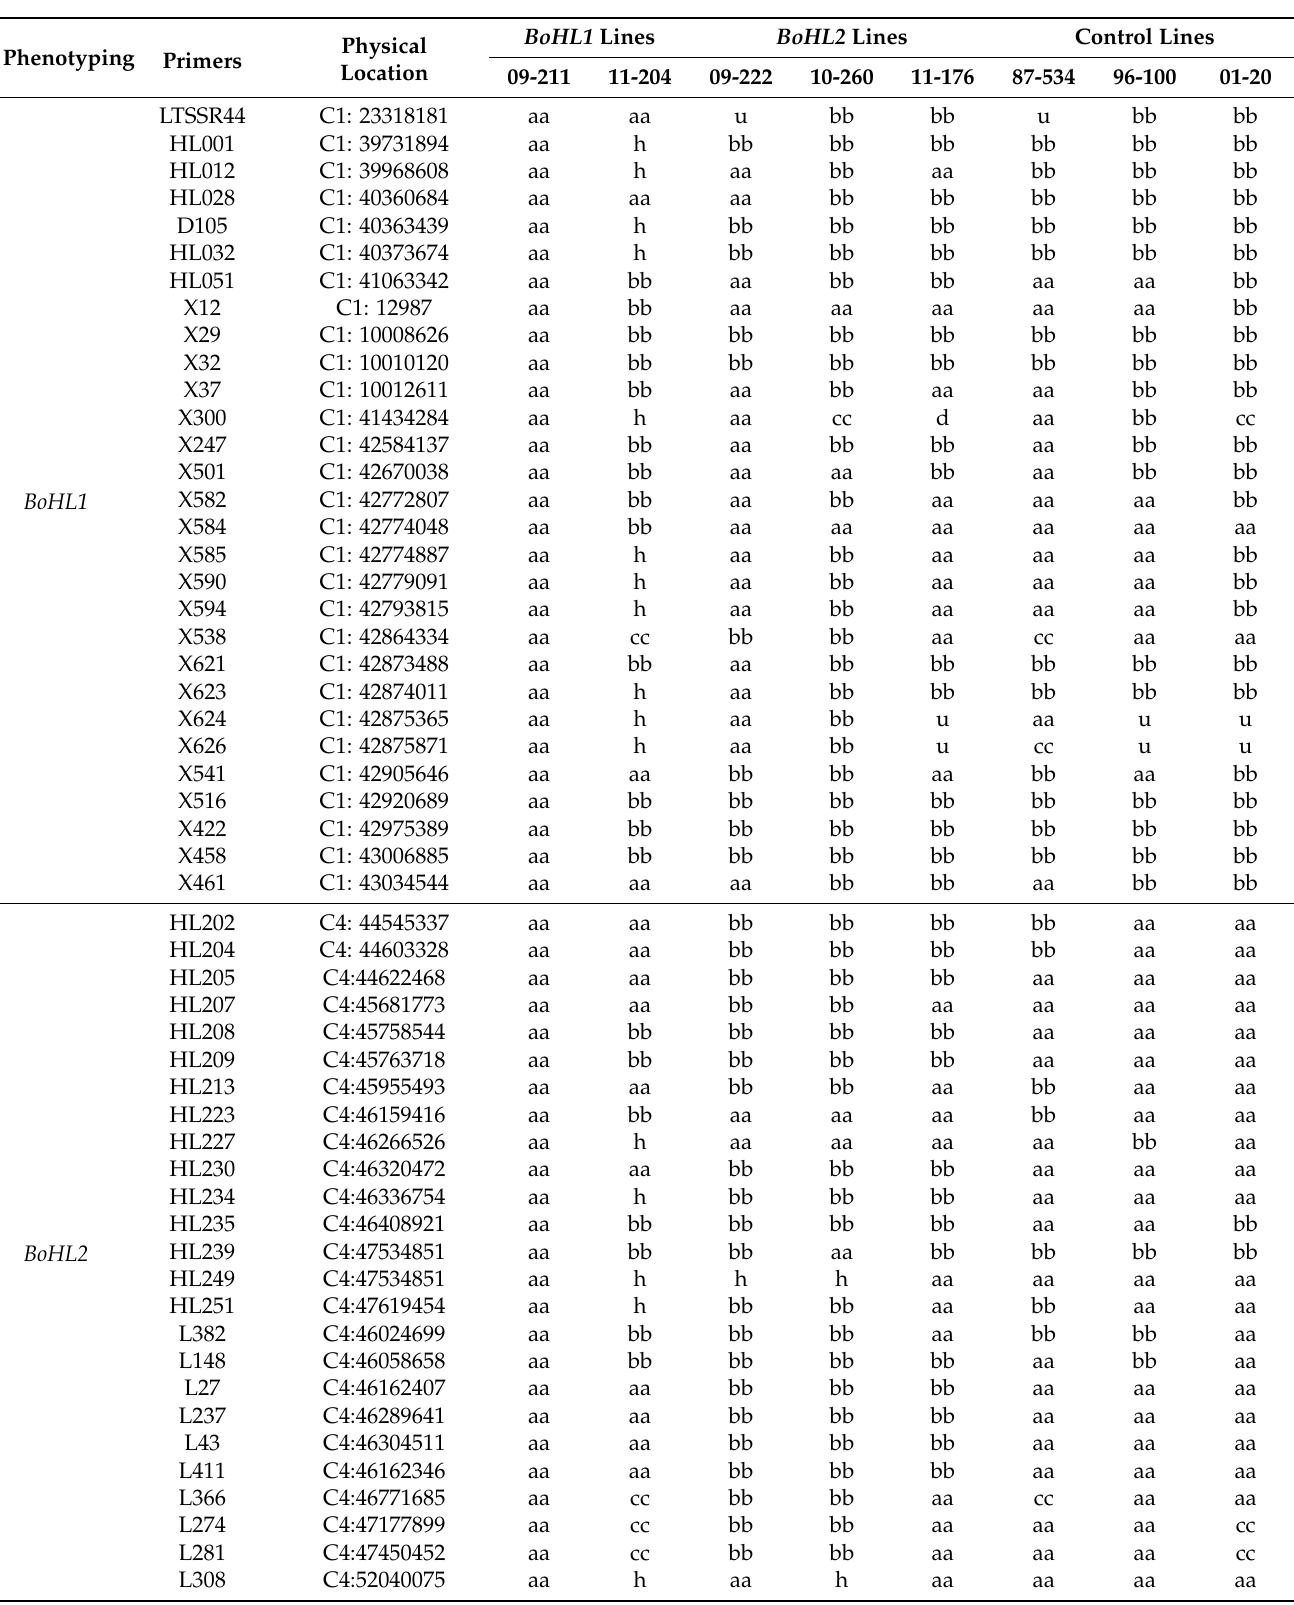
Table 1. Phenotyping of 54 pairs of fine mapping markers in eight cabbage lines. BoHL1 genotypes, normal genotypes, heterozygous genotypes, other genotypes and no amplified bands were recorded as “aa”, “bb”, “h”, “cc” and “no”,